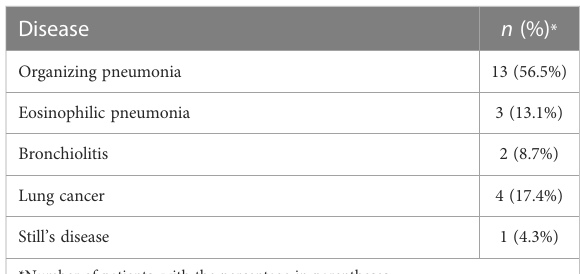
TABLE 3 Distribution of non-infectious pulmonary diseases.